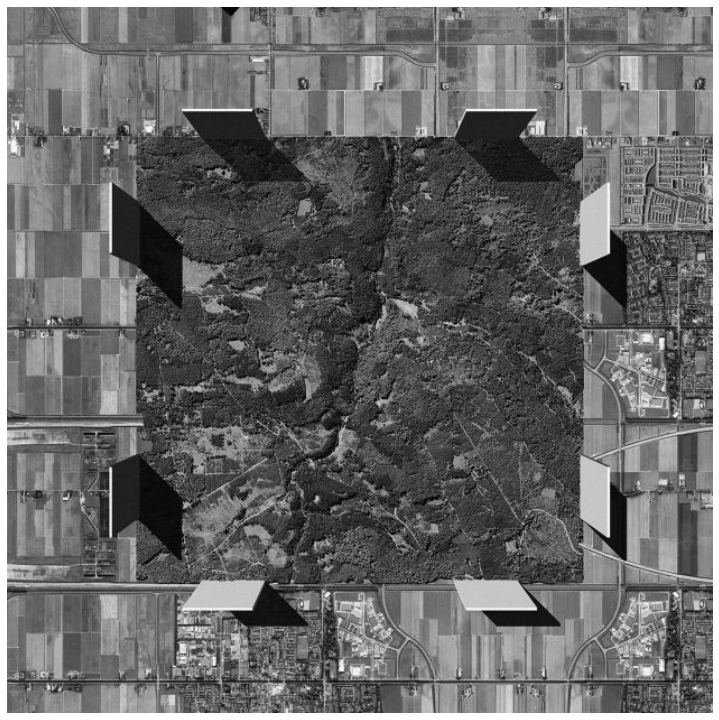
Fig. 1 IKONOSPAN city and farmland